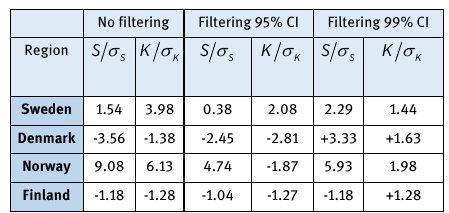
Table 2. The standardised skewness and kurtosis values before and after filtering of the discrepancies based on CIs of 95% and 99.7%